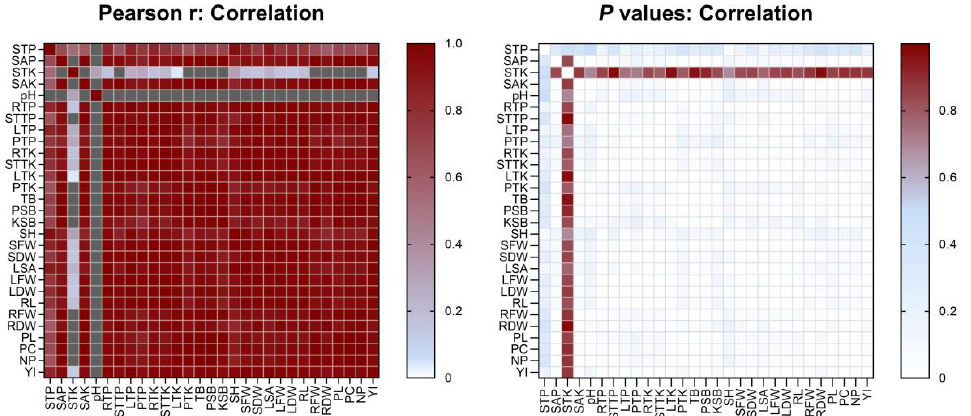
Figure 4. Pearson correlation coefficients between soil-plant nutrients, culturable bacteria, plant growth and yield. Colour indicates the relationship strength for r-correlation (red, strong; blue, medium; white, low; grey, negative) and statistical significance for p -value (red, non-significant; blue, significant; white, very significant). Soil total P, STP; soil available P, SAP; soil total K, STK; soil available K, SAK; stem total P, STTP; root total P, RTP; leaf total P, LTP; pod total P, PTP; stem total